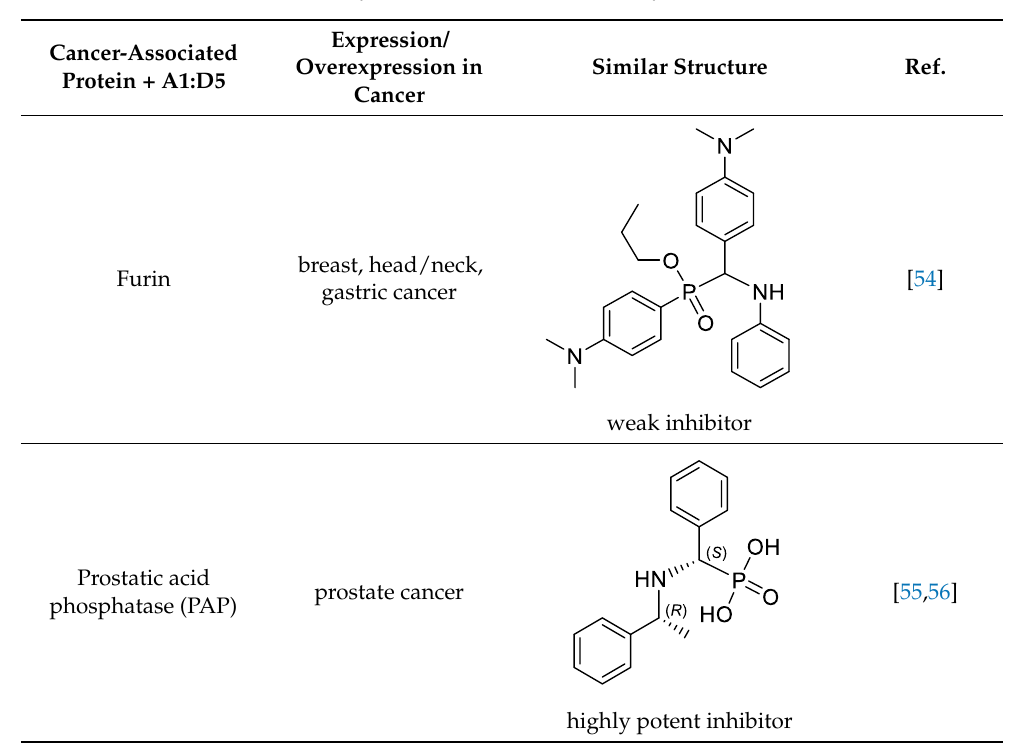
Table 5. Target annotation of known bioactive compounds found similar to the cytotoxic hits ( 2b , 2d , 2e ). Note : the annotated bioactivity databases often lack chirality information.